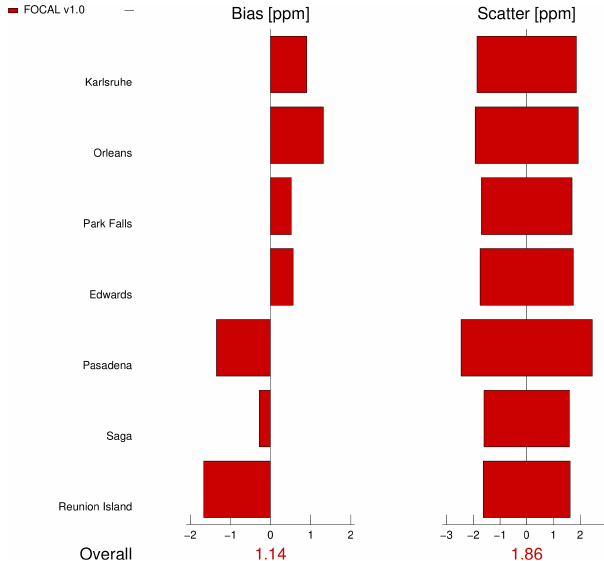
Figure 18. Overview of TCCON validation results for the GOSAT- 2-FOCAL product.